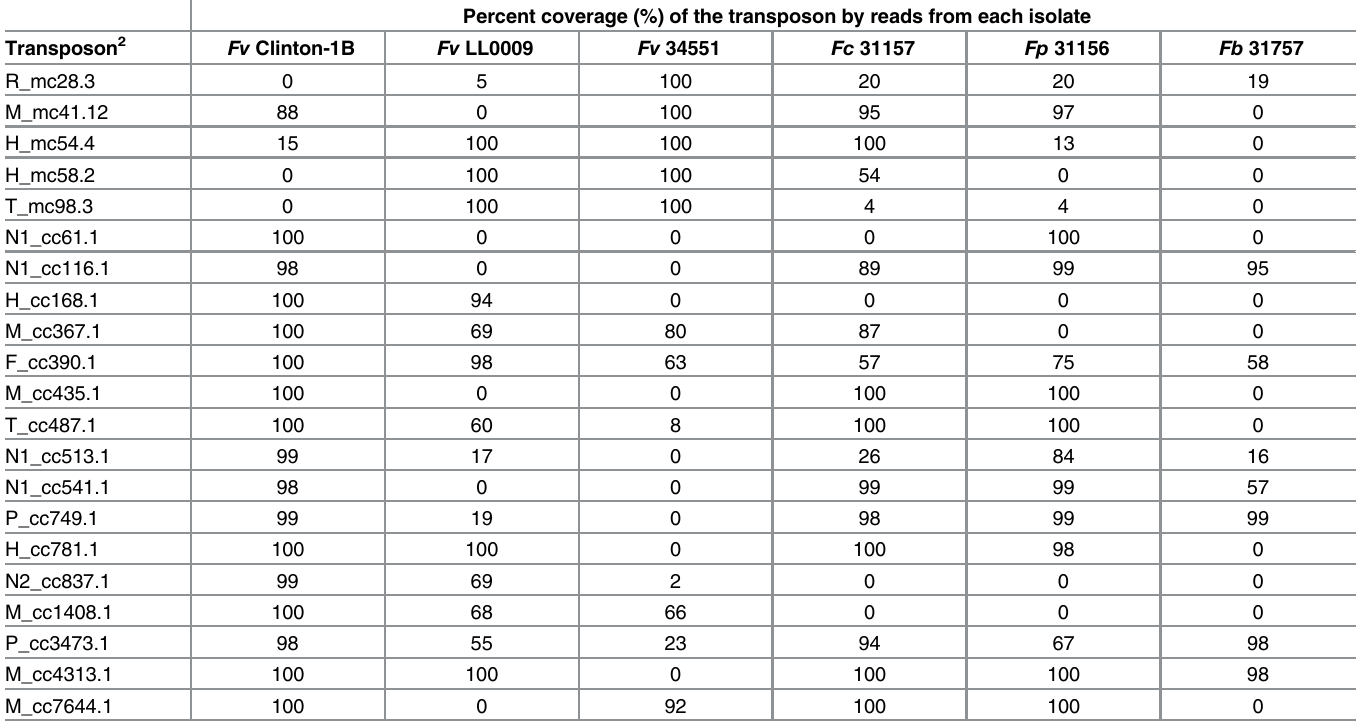
Table 6. Breadth of coverage of the transposon at a minimum depth of 25 reads 1